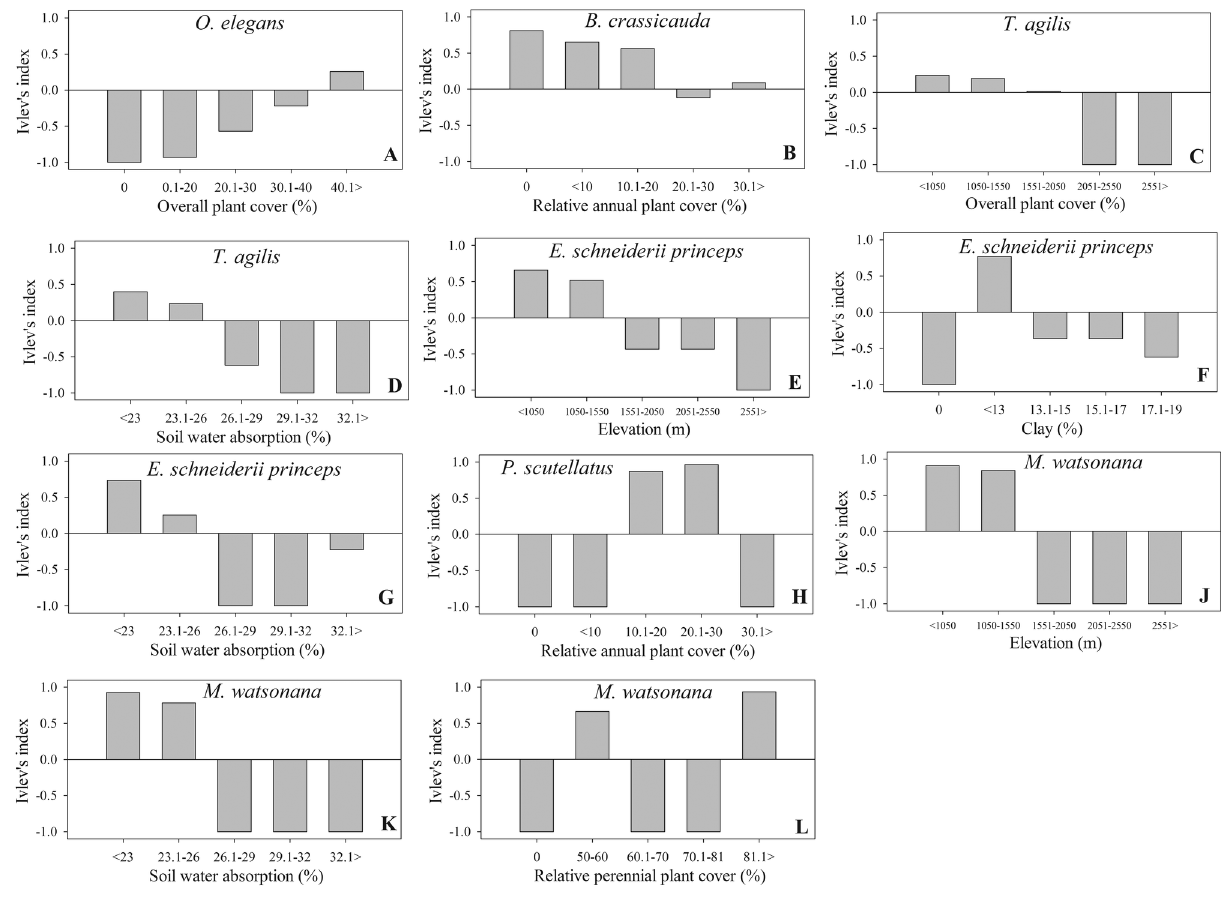
Figure 5. Habitat variable ranks for six lizards species in the Qom Province of Iran that had significant relationships with habitat variables. The value of the selectivity index is shown and each variable is divided to five